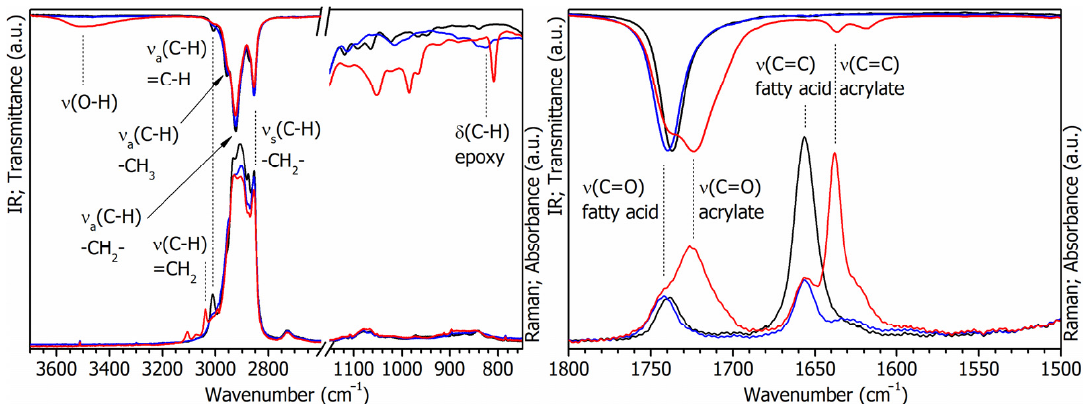
Figure 2. Vibration spectra of ME_RO (black), EME_RO (blue), and AME_RO (red).